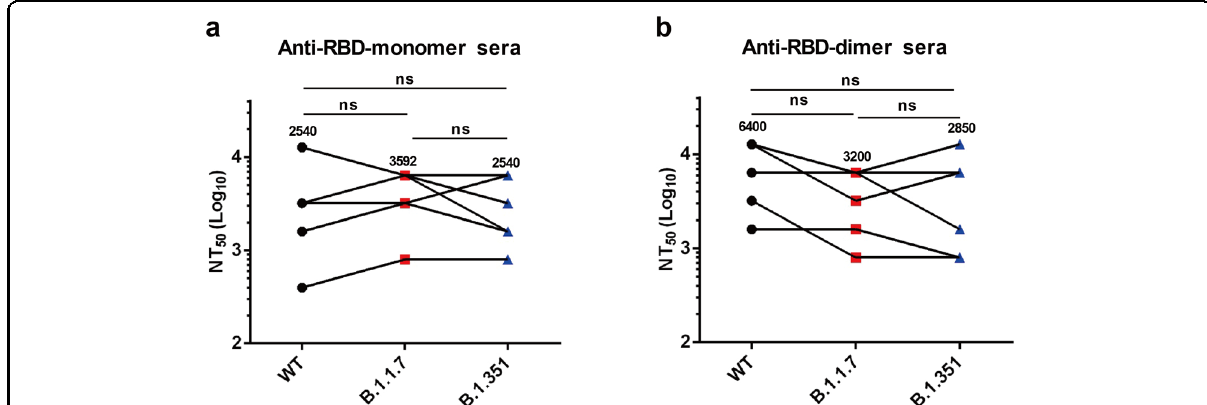
Fig. 7 Antisera induced by the yeast-derived monomeric and dimeric RBD vaccines ef fi ciently neutralized SARS-CoV-2 variants. Neutralizing titers of week-6 anti-RBD-monomer ( a ) and anti-RBD-dimer sera ( b ) against B.1.1.7 and B.1.351 variants were measured using pseudovirus neutralization assay. For comparison, NT50s of antisera against WT pseudovirus (Fig. 6c) were also shown. Geometric means were calculated for each data set and shown. Each symbol represents one mouse. Statistical signi fi cance was determined by Student ’ s t -test and indicated as follows: ns, not signi fi